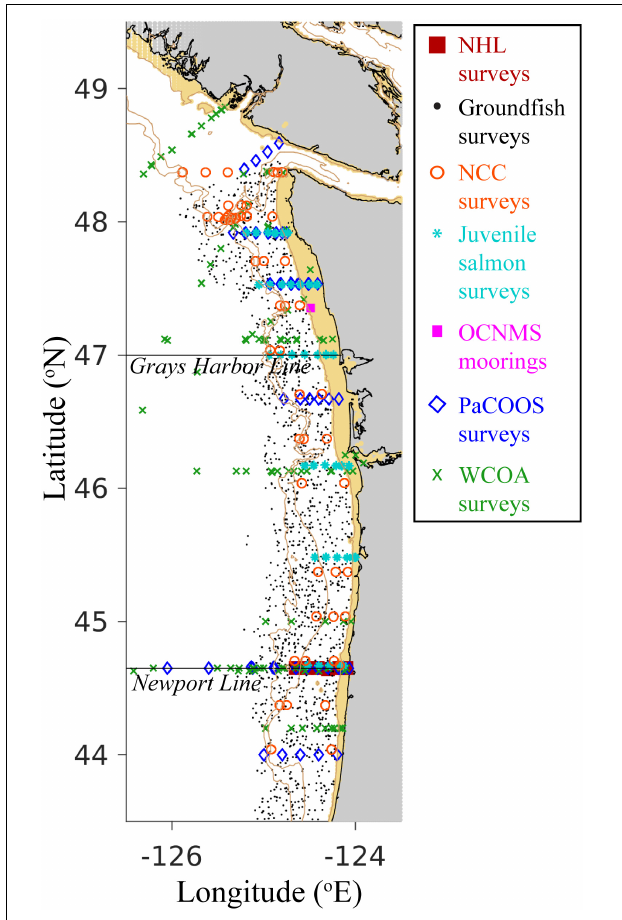
FIGURE 2 | Empirical observation sampling locations used to assess the skill of J-SCOPE modeled ocean variables. Survey and mooring symbols correspond to the figure legend, with tiny black dots representing groundfish survey locations. The Grays Harbor Line and the Newport Line, two common hydrographic transects, are plotted for reference. The 200 and 500 m isobaths are indicated by light brown contours, and depths shallower than 50 m are shaded light brown. Land is shaded gray. NHL = Newport Hydrographic Line; NCC = Northern California Current; OCNMS = Olympic Coast National Marine Sanctuary; PaCOOS = Pacific Coast Ocean Observing System; WCOA = West Coast Ocean Acidification. See Supplementary Table 2 for additional information on sampling dates, depths, and measured